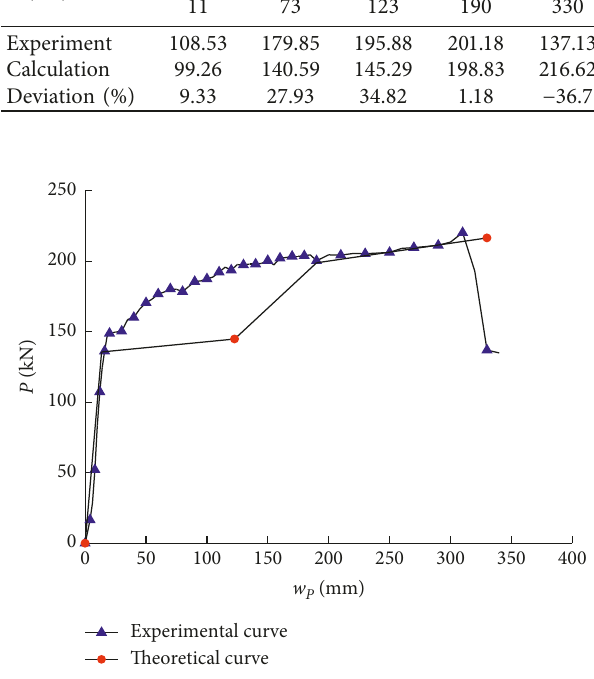
Figure 12: Resistance curves of the CFSTSBF specimen.